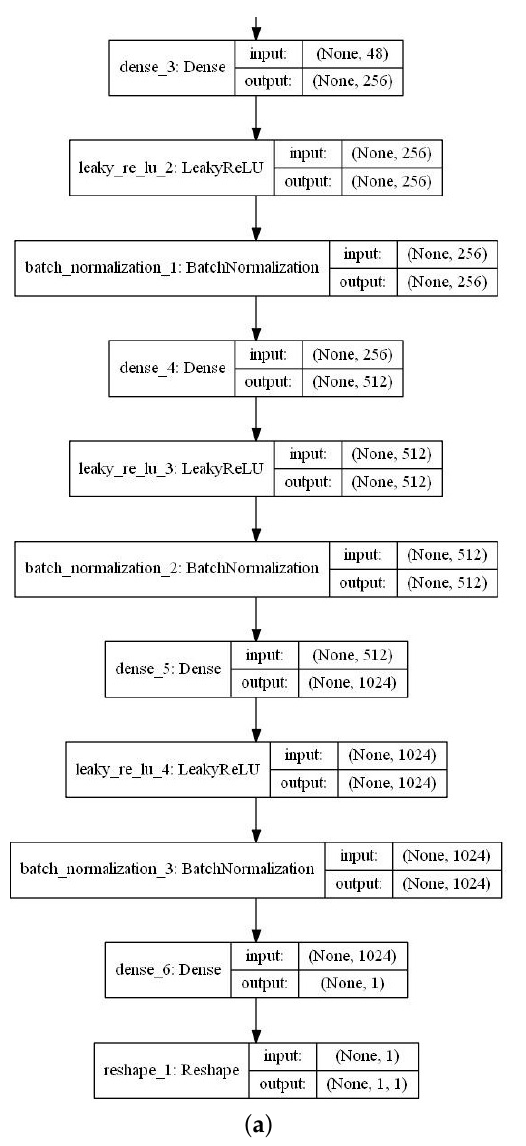
Figure 13. GAN structure for time series forecasting task ( a ): Generator ( b ):